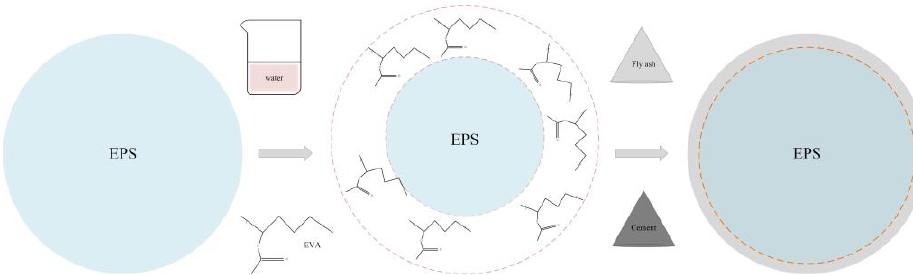
Figure 3. EVA and EPS shell-making